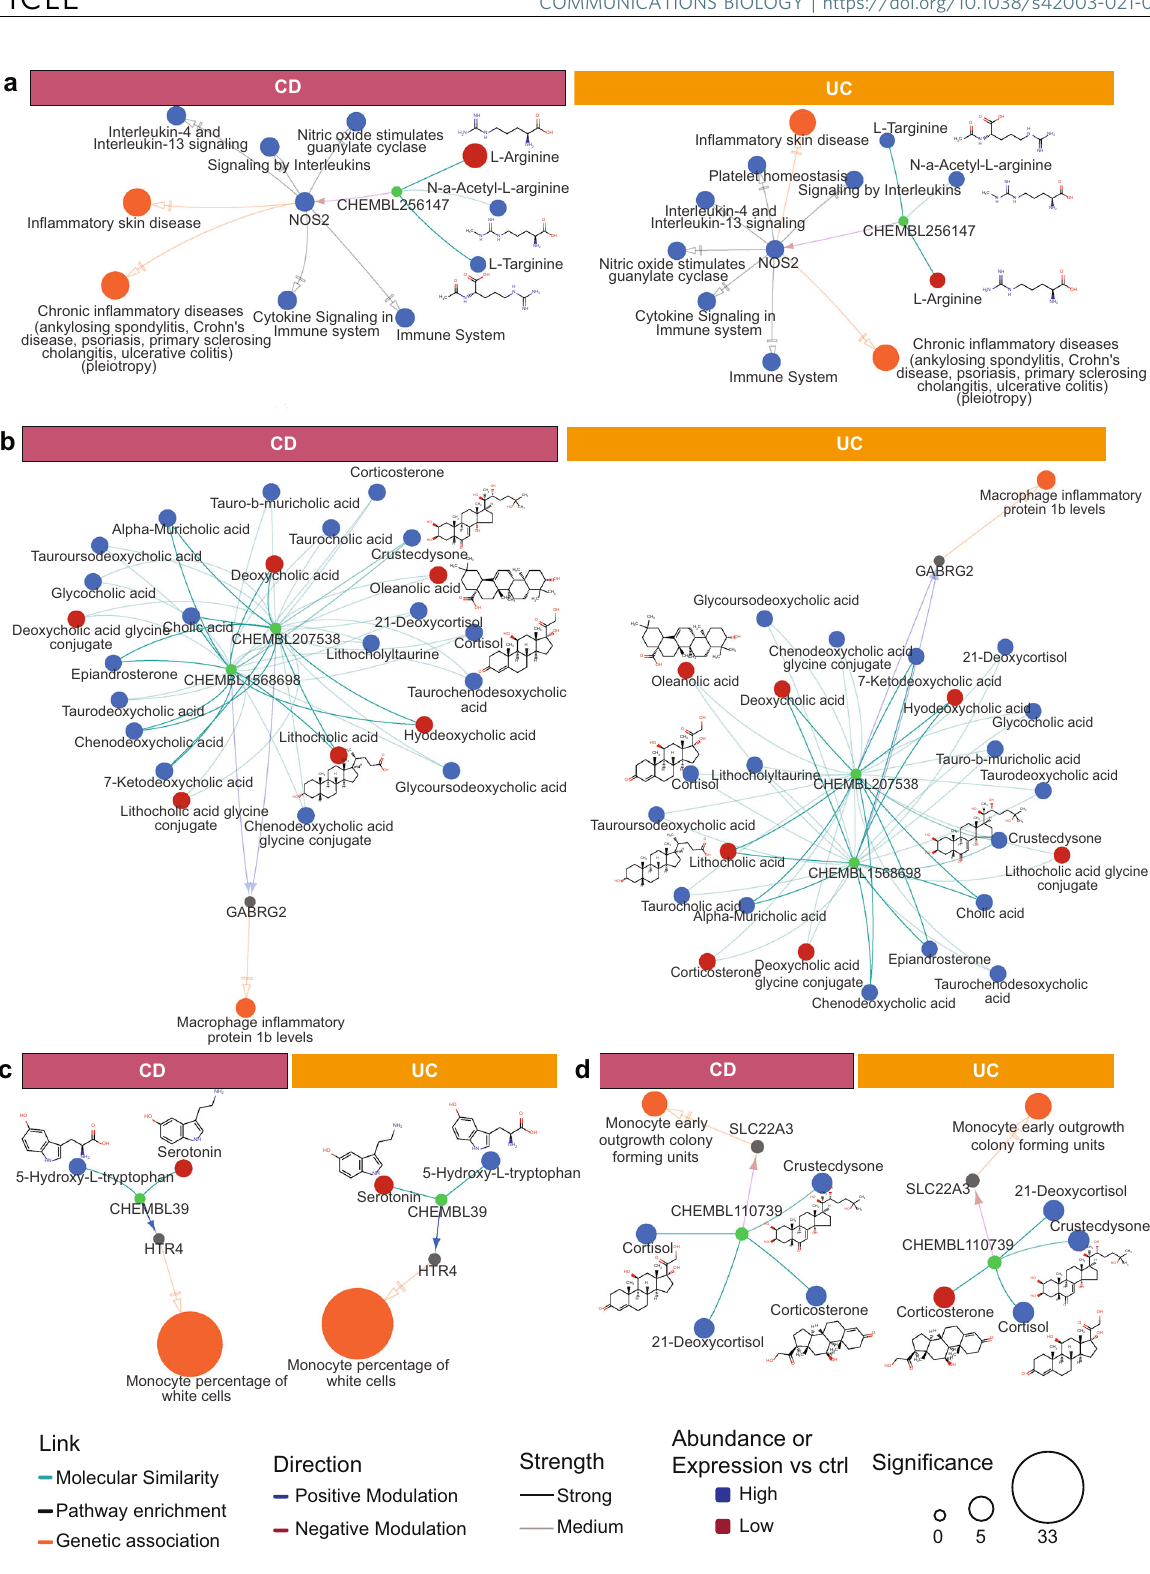
Fig. 4 Overview of identi fi ed for putative target proteins. Metabolites were connected through similar ChEMBL compounds where similarity is classi fi ed as medium (0.8 < Tanimoto score < 0.9) or strong (Tanimoto score > 0.9) for ( a ) CXCR1/2 and NOS2, ( b ) HTR4, ( c ) GABRG2 and ( d ) SLC22A3. Direction and af fi nity of analog binding to target was parsed from ChEMBL assay databases and represented as medium (5.5 < pxC 50 < 7.0) and strong (pxC 50 > 7.0). Direction (i.e., up- or down-) of differential expression for targets or differential abundance for metabolites are represented by colors. Target signi fi cance (log q value) is based on differential expression of the gene or GWAS association. Complete results for targets with genetic evidence are shown in Supplementary Fig.